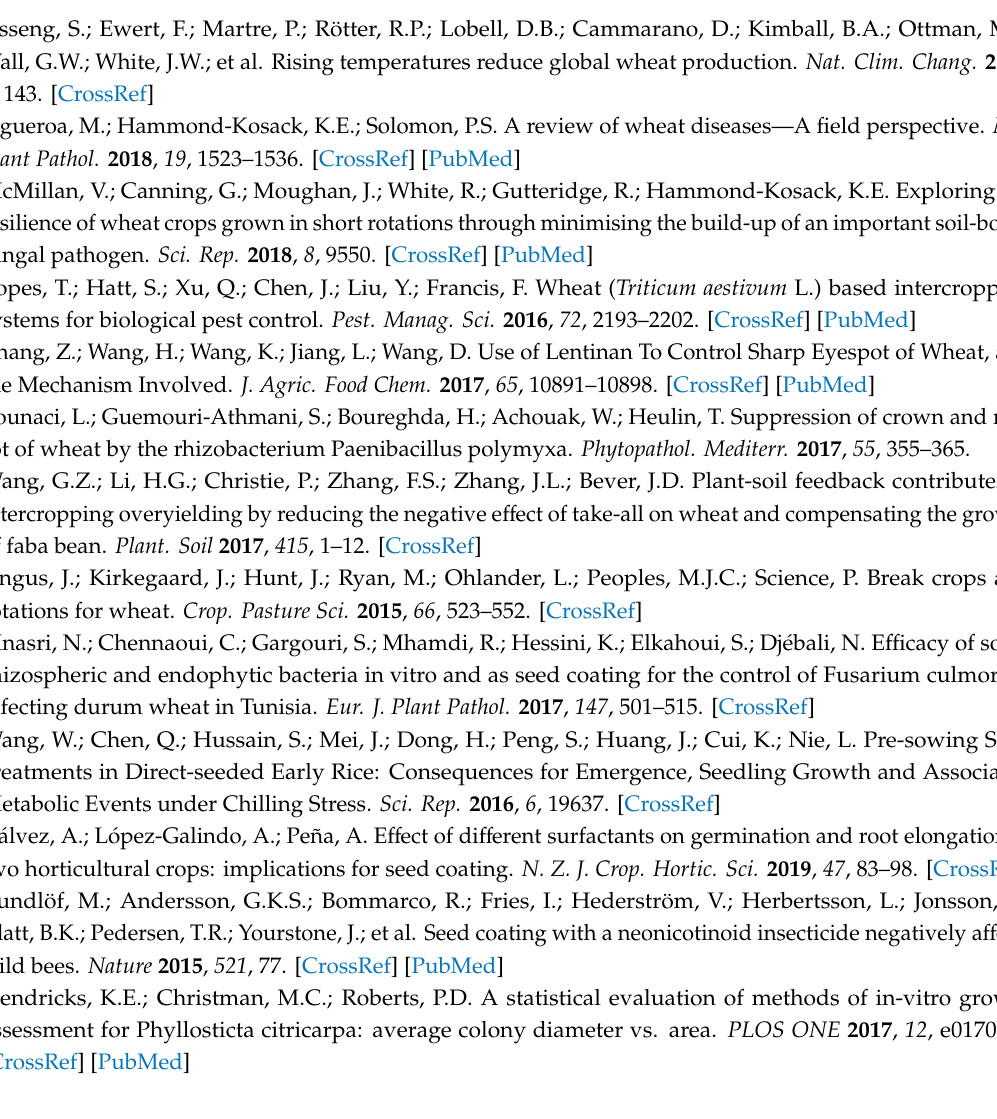
Table S1: Property of the nonionic